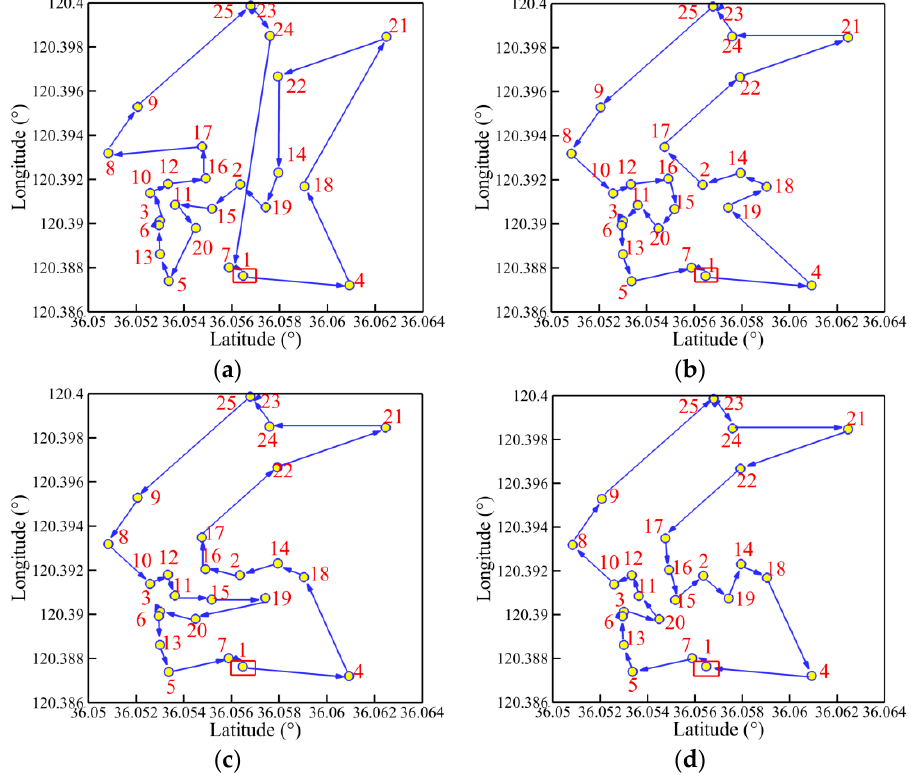
Figure 16. Trajectory planned by each algorithm for P = 25: ( a ) CGA; ( b ) SDIGA; ( c ) DDIGA; ( d ) MDIGA.